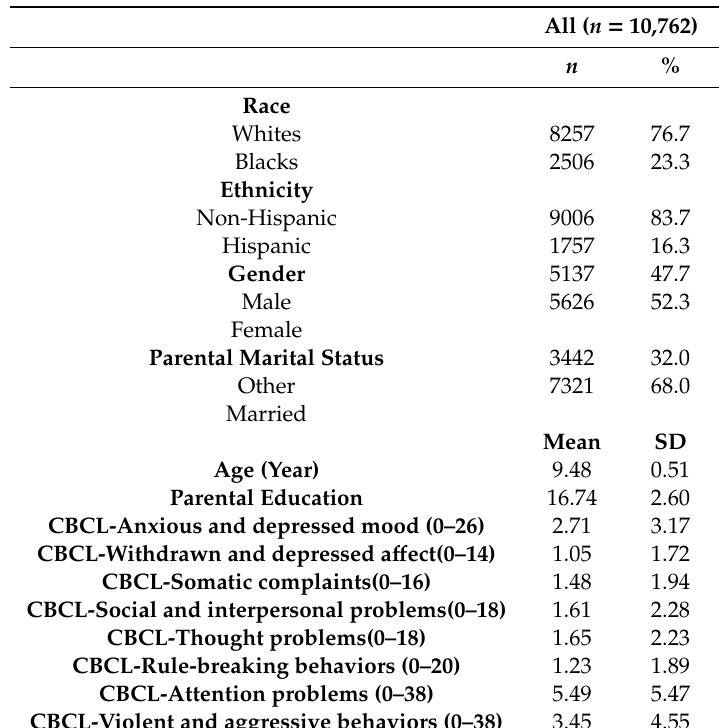
Table 2. Descriptive data